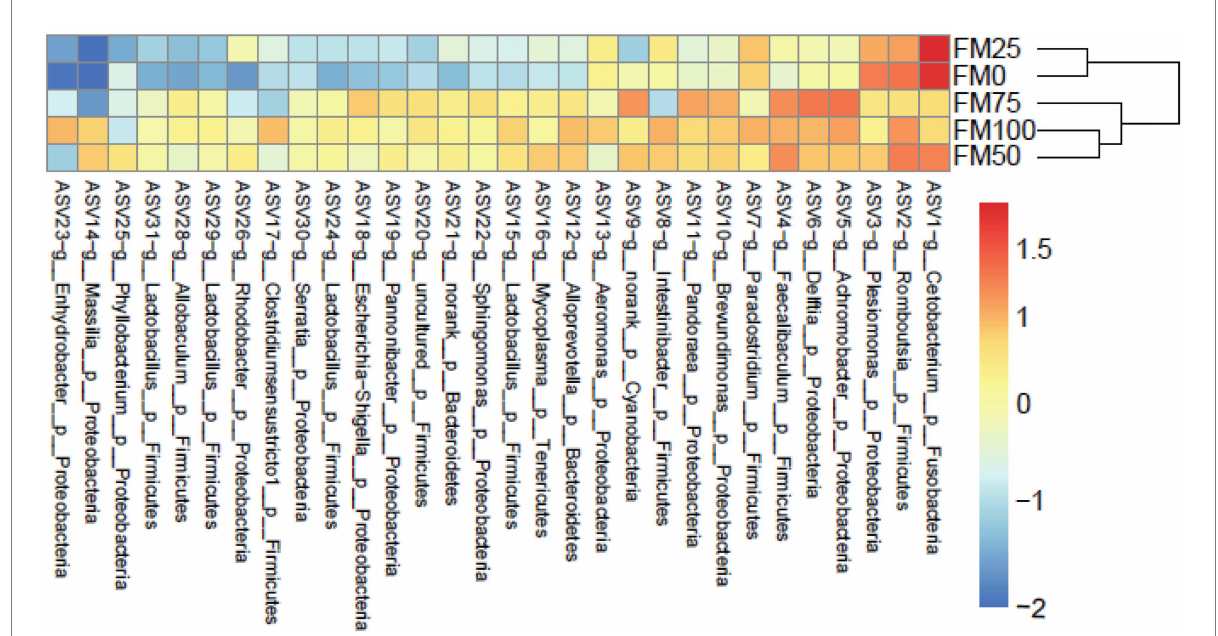
FIGURE 4 Heatmap showing the relative abundance reveals the compositional differences of the gut microbiota of largemouth bass fed with different levels of Chlorella meal diets. Bray-Curtis clustering based on the top 30 ASVs in the gut microbiota. FM100 represents the fishmeal diet without Chlorella meal; FM75, FM50, FM25, and FM0 represent the fishmeal diet with 25, 50, 75, and 100% fishmeal replacement by Chlorella meal,